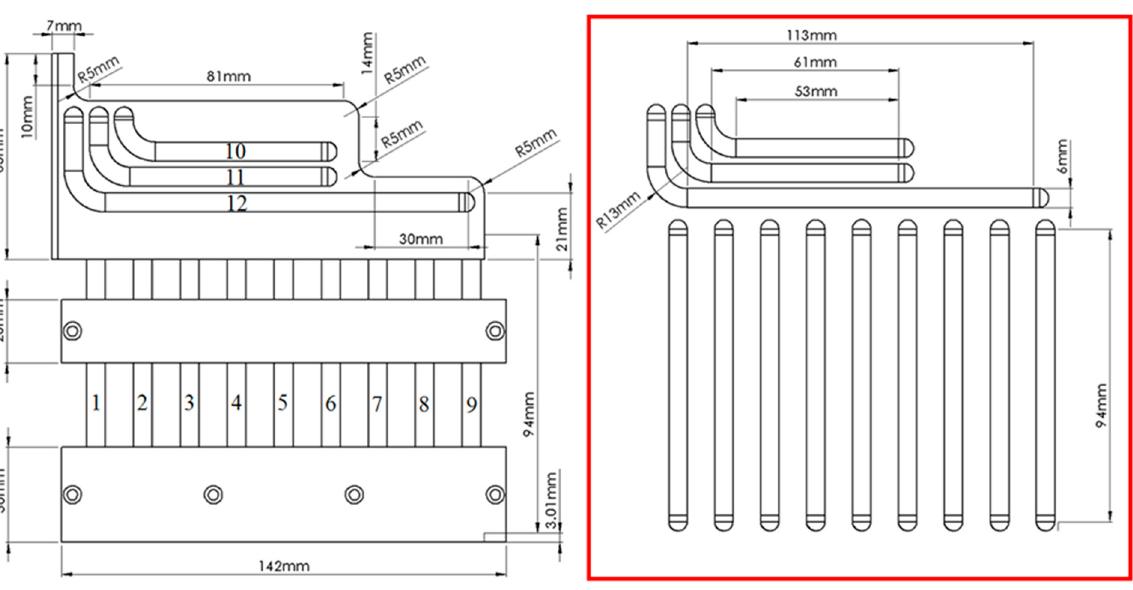
Figure 5. Configuration of Type II cold plate.